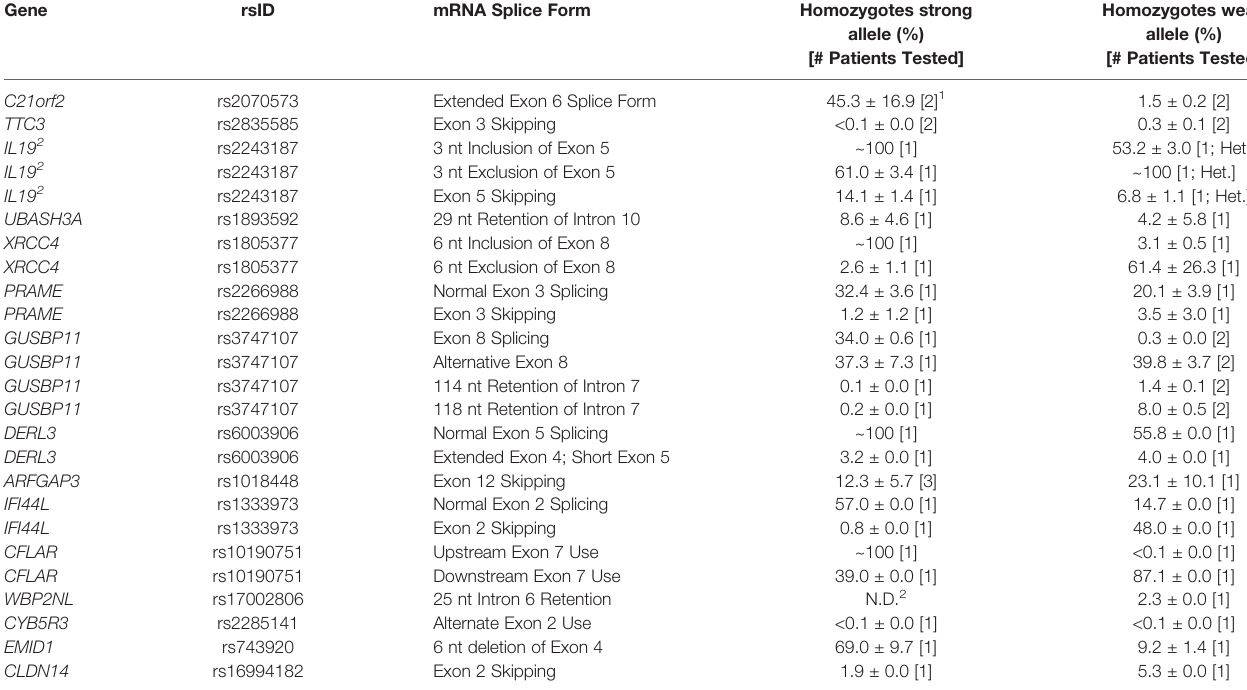
TABLE 2 | Abundance of mRNA splice forms relative to internal gene reference. Gene rsID mRNA Splice